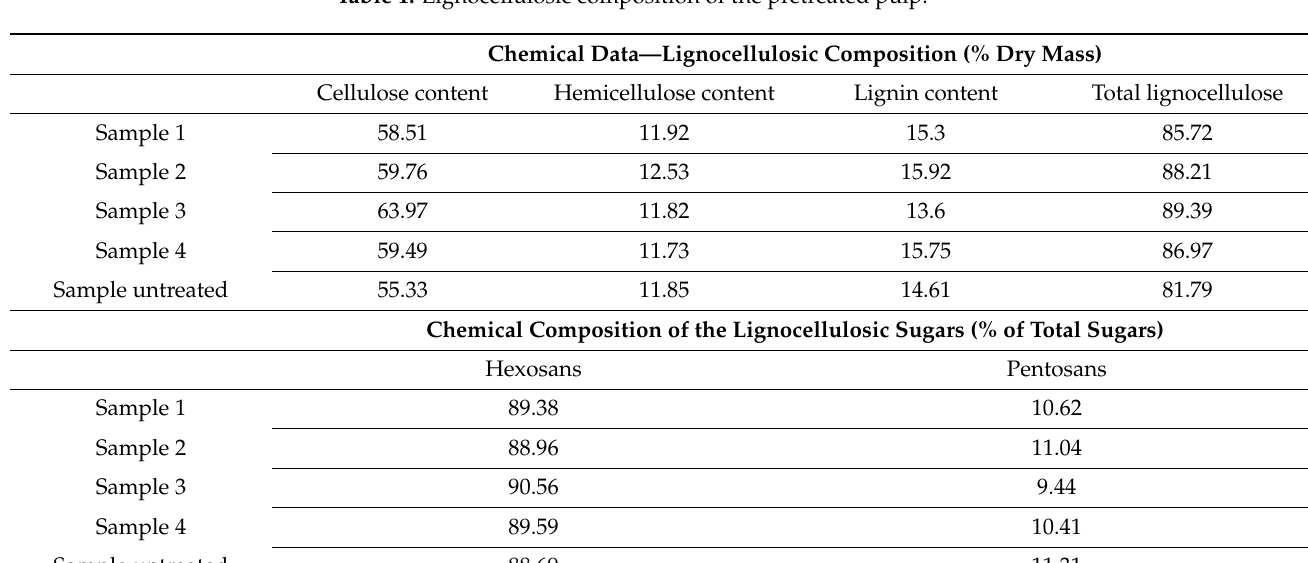
Table 1. Lignocellulosic composition of the pretreated